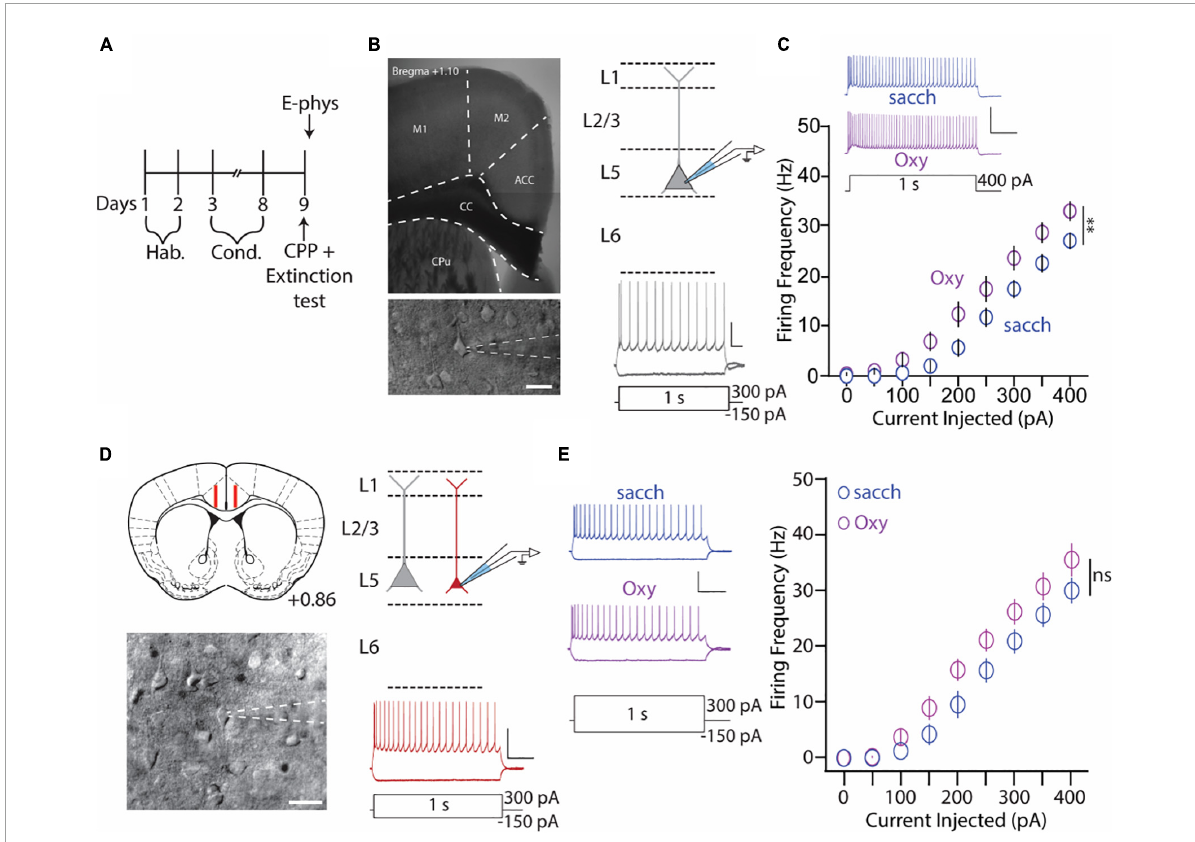
FIGURE3 Anterior cingulate cortex (ACC) L5 thick-tufted, but not thin-tufted, PyNs have increase in the intrinsic membrane excitability during 1 day abstinence from oxycodone (0.5 mg/ml) self-administration. (A) Experimental timeline showing that electrophysiology assessments were performed immediately after the 2 h extinction test. (B) 4 × image of a brain slice containing the ACC (top) and 40 × image of an ACC thick-tufted pyramidal neuron targeted for electrophysiological assessments (bottom). These neurons are located within layer 5 of the ACC (top, right) and express a SAG current (bottom, right). Scale bar (image): 20 µ m. Scale bar (electrophysiology trace): 25 mV, 100 ms. (C) Summary graph showing that following the 2 h extinction test, the number of action potentials fired in L5 thick-tufted PyNs is significantly increased in mice orally self-administering oxycodone vs. vehicle controls. Scale bars: 50 mV, 200 ms [ F ( 8 , 208 ) = 2.615, p = 0.0095, two-way repeated-measures ANOVA with Bonferroni post hoc test] (saccharin: n = 12/4; oxycodone: n = 16/4; cells/mice). (D) Illustration of the targeted region in red (layer 5) for recording thin-tufted pyramidal neurons in a brain slice containing the ACC. (Bottom) Illustration of a thin-tufted PyN targeted for electrophysiology recordings with distinct morphological (top, right) and electrophysiological (bottom, right) electrophysiological characteristics. Scale bar (image): 20 µ m. Scale bar (electrophysiology trace): 50 mV, 200 ms. (E) Representative traces (left) and summary graph (right) showing no significant difference in IME following oxycodone SA in ACC L5 thin-tufted PyNs [ F ( 8 , 120 ) = 1.689, p = 0.1078, two-way